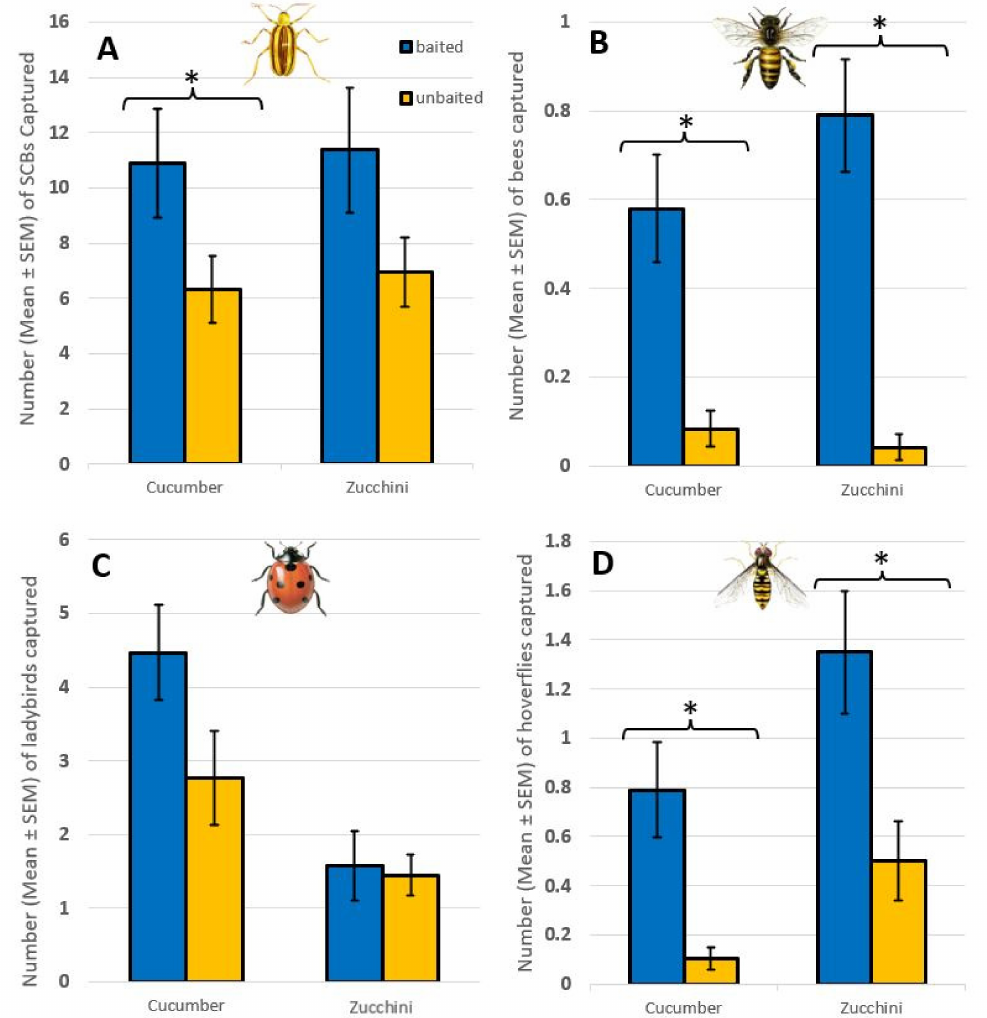
Figure 1. Number of SCBs, ladybirds, bees, and hoverflies captured in baited and unbaited traps in cucumber and zucchini plots (ANOVA). ( A ) SCB—cucumber: F 1,106 = 3.94; p < 0.05; zucchini: F 1,106 = 2.89; p = 0.09, ( B ) bees—cucumber: F 1,94 = 15.11; p < 0.001; zucchini: F 1,94 = 33.54; p < 0.001, ( C ) ladybirds—cucumber: F 1,94 = 3.56; p = 0.06; zucchini: F 1,94 = 0.05; p = 0.82, ( D ) hoverflies— cucumber: F 1,94 = 11.80; p < 0.001; zucchini: F 1,94 = 8.36; p < 0.01). Asterisks above bars